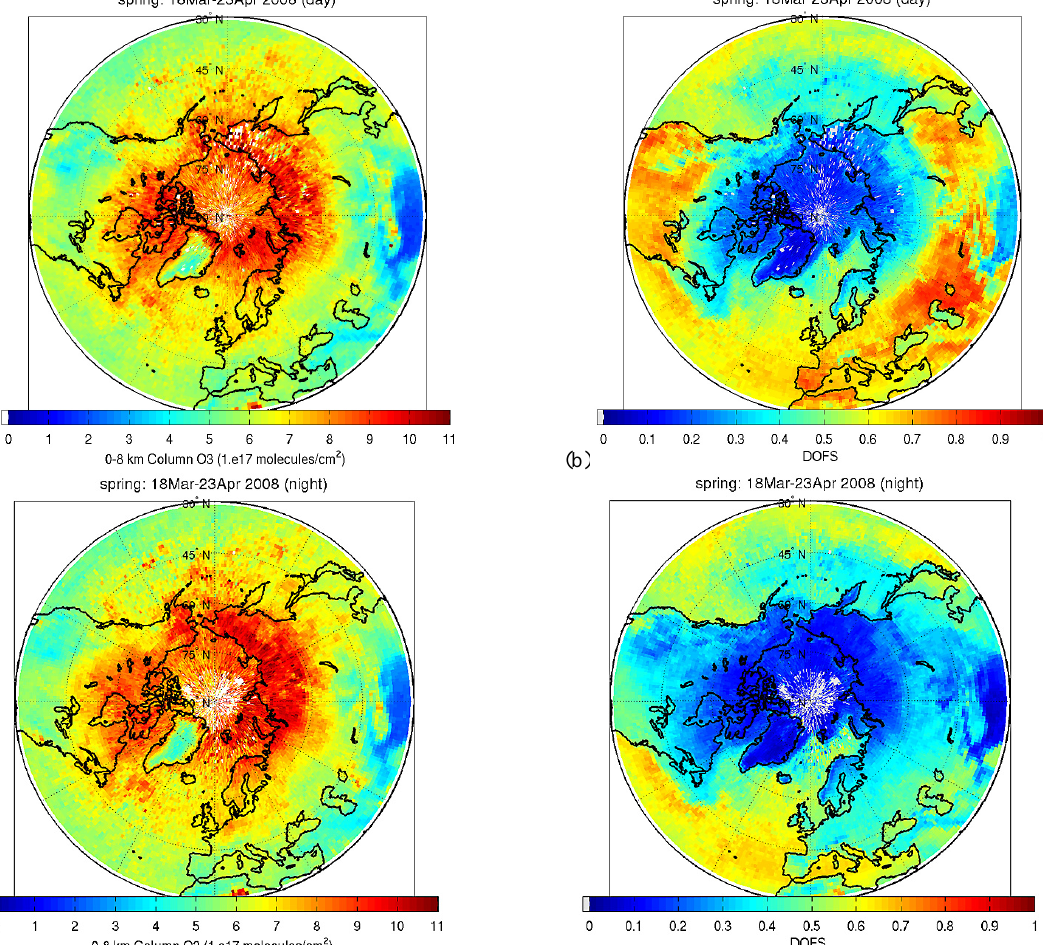
Fig. 4. Maps of IASI [0–8km] O 3 columns (a) and corresponding DOFS (b) on a 1 ◦ × 1 ◦ grid for the spring campaign for daytime (top) and night-time (bottom). White areas indicate no